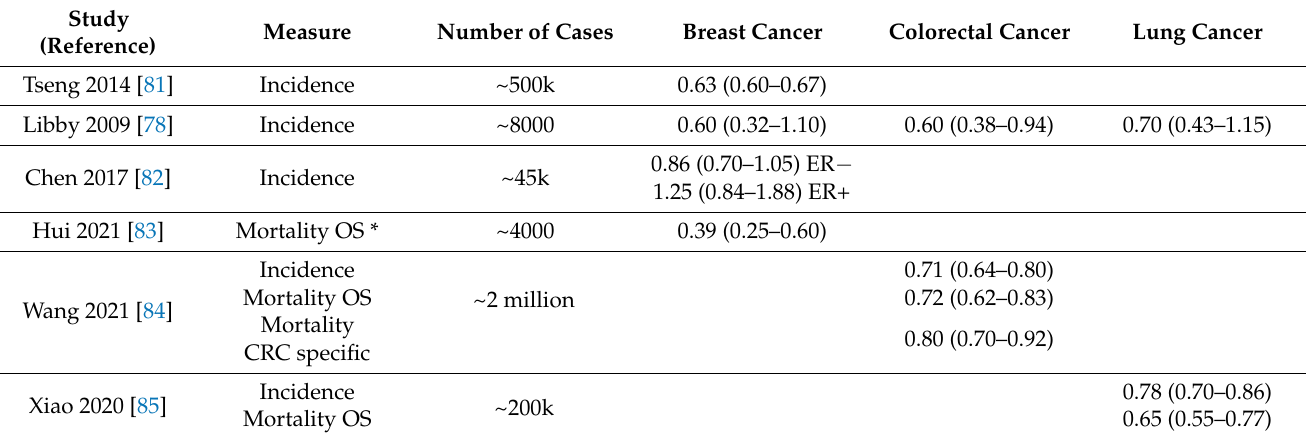
Table 4. Effect of metformin vs. active comparator in T2DM patients on cancer incidence and